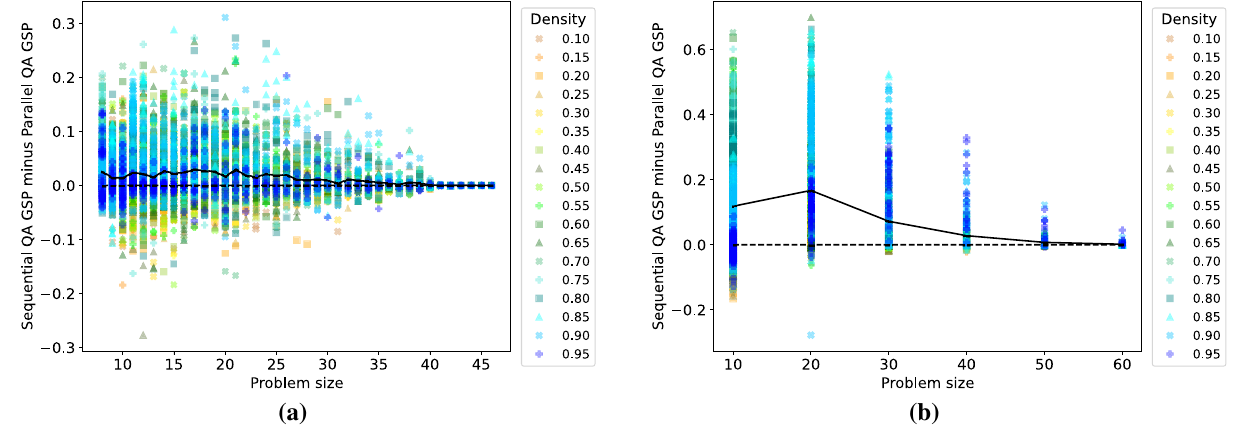
Figure 4. Difference between the ground state probabilities (GSP) of sequential and parallel quantum annealing as a function of the problem size for DW 2000Q ( a ) and DW Advantage ( b ). Values above zero indicate that sequential quantum annealing finds higher ground state probabilities than parallel quantum annealing. Averages indicated with a solid black line. Graph densities range from 0.10 to 0.95 (color coding shown in legend).